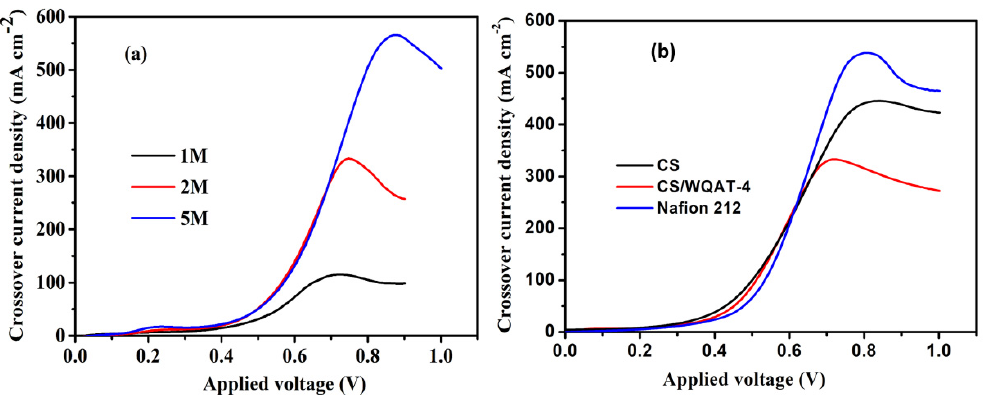
Figure 7. Comparison of the methanol crossover current densities of ( a ) CS/WQAT ‐ 4 at 70 °C in methanol solutions with different methanol concentrations; ( b ) CS, CS/WQAT ‐ 4 and Nafion 212 at 70 °C in a 2 M methanol solution.